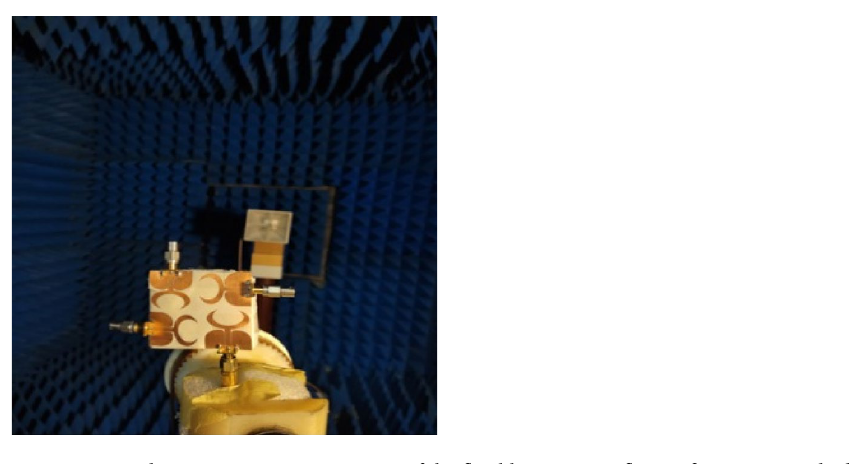
y–z plane with a reasonable matching between them. While the pattern is slightly tilted in the y–z plane, this is because of the bending effect around the cylindrical foam layer as shown in Fig. 18. The simulated and tested results of the peak gain are shown in Fig. 19. The antenna has tested gain ranging from 3 dBi at the beginning to 6.3 dBi at the end of the band with a good tendency between the results at R = 45 mm.